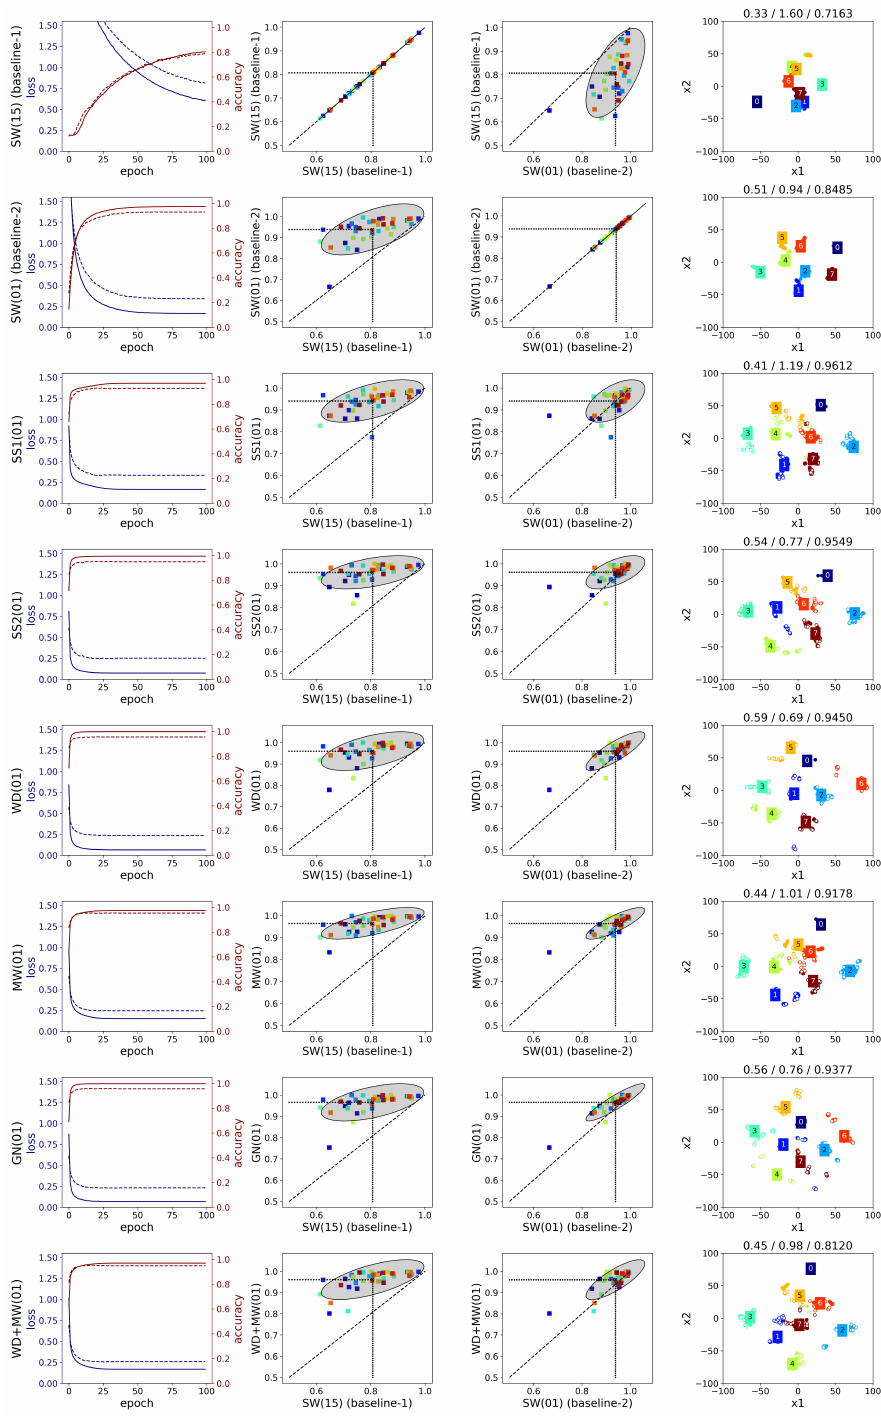
Figure A7. Average loss and accuracy graphs (left) , augmentation vs. baseline-1 and baseline-2 accuracy per subject ( middle ), and t-SNE embeddings of a single subject ( right ) for the different augmentation methods on putEMG. The investigated method is shown on the left of the figure. In the left plot, the solid lines correspond to training, while the dashed lines to testing. In the middle plots, color points correspond to different subjects and the ellipse shows the general shape of the points. In the t-SNE visualizations, color points correspond to different gestures, while the values at the title are the SC/DB/accuracy